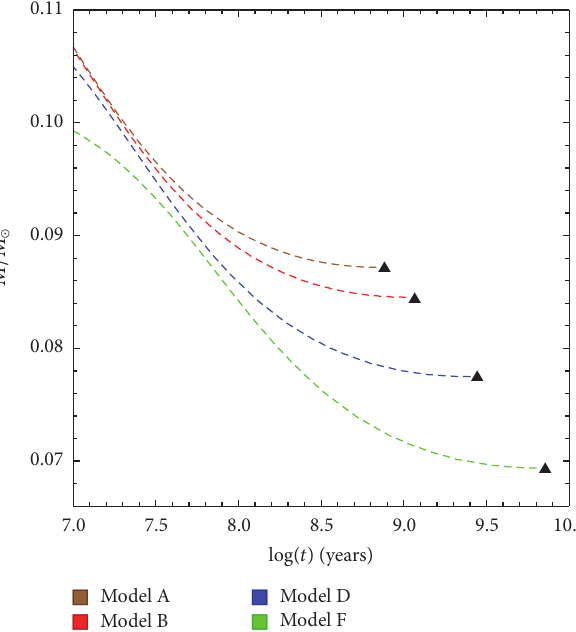
Figure 5: The time needed to reach the main sequence, that is, /𝐿 = 1 , for objects of different masses. Four colored dashed lines 𝐿 𝑁 represent different models as labeled. The triangles mark the main- sequence critical mass for the respective